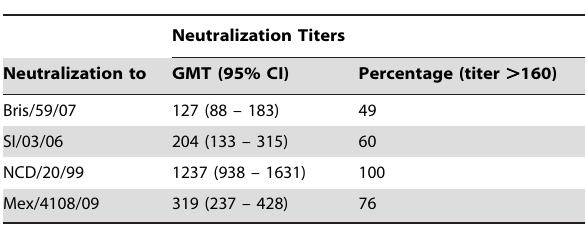
Table 3. Summary of neutralization titers of contemporary sera from subjects with a history of having received seasonal influenza